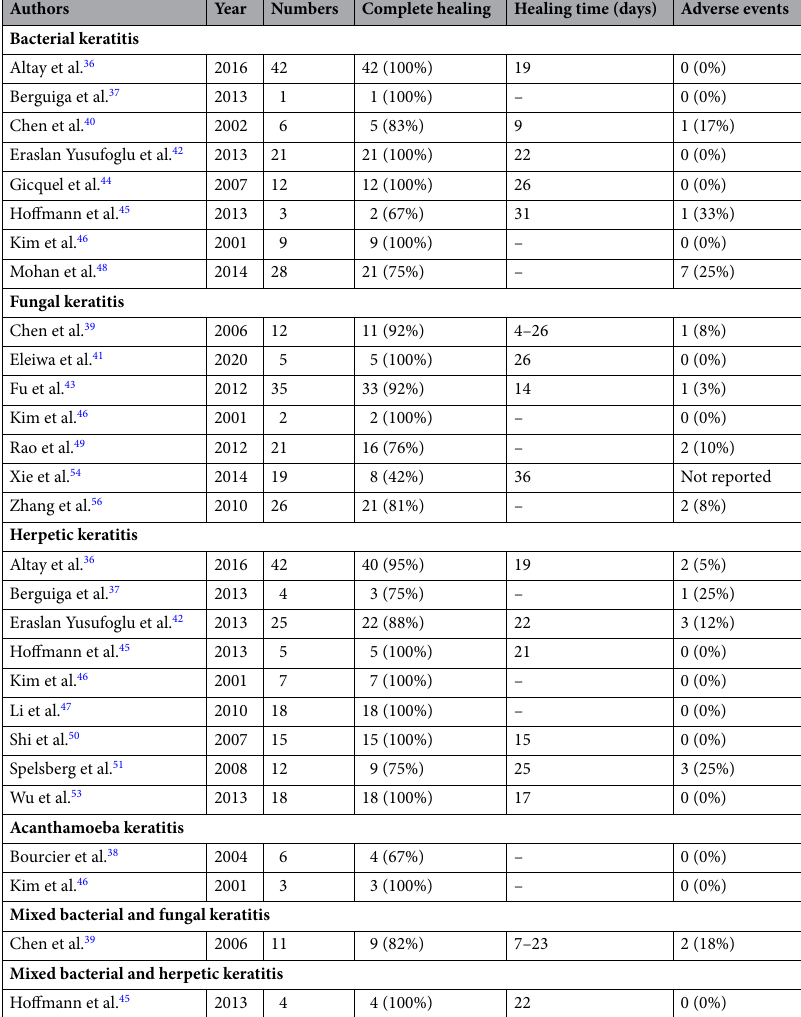
Table 5. Summary of the healing rate and treatment failure of amniotic membrane transplantation (AMT) in large case series (N > 5 eyes) based on the types of causative